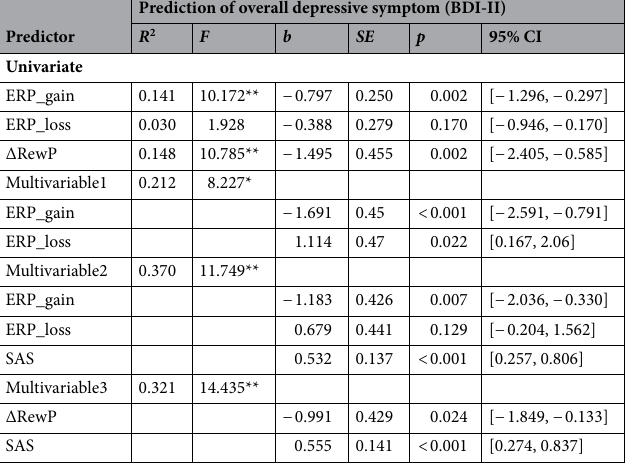
Table 3. Results from the linear regression analyses predicting overall depressive symptoms from ERPs. R 2 effect size of the model, F statistical value of F test, b regression coefficient, SE standard error, CI confidence interval, ΔRewP reward positivity, BDI-II Beck Depression Inventory Second Edition, SAS Self-Rating Anxiety Scale, ERP_gain gain-feedback-locked ERP component, ERP_loss loss-feedback-locked ERP component. * p < 0.05; ** p < 0.01.